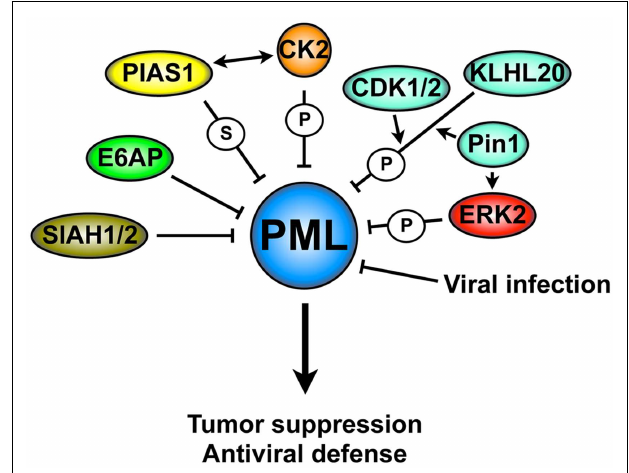
FIGURE 4 | Mechanisms of PML degradation. A complex molecular network is involved in PML degradation: these mechanisms include several post-translational modifications that trigger PML ubiquitination and degradation, resulting in the loss of its tumor suppressive activity or antiviral properties. S, SUMOylation; P,